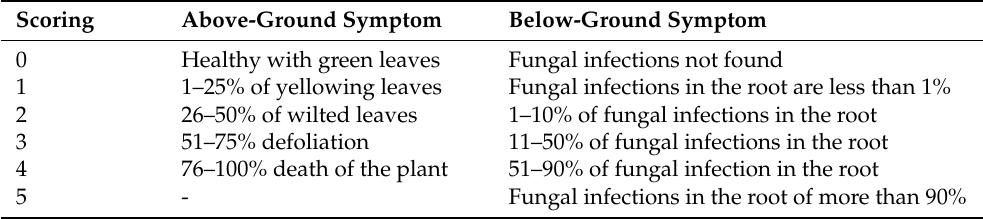
Table 2. Assessment of the disease severity index based on the justifications of above- and below- ground